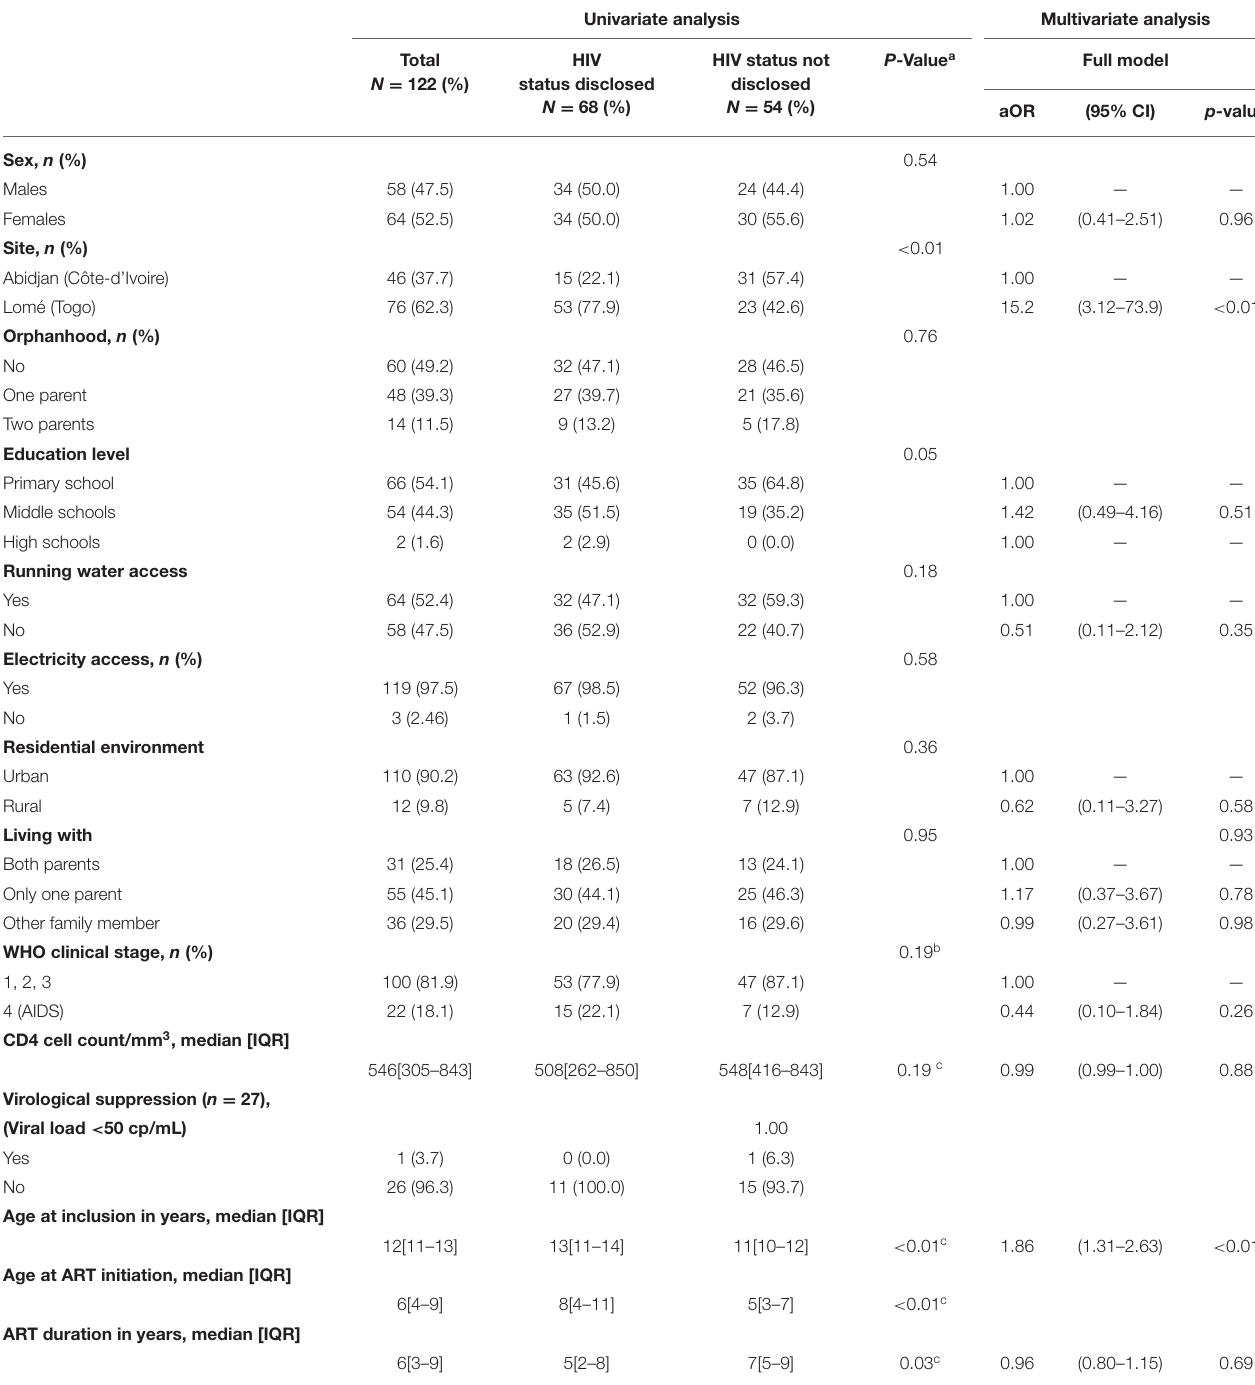
TABLE 4 | Correlates of HIV disclosure at 24-month among the 122 APHIV not disclosed at inclusion, in the COHADO cohort, Abidjan (Côte d’Ivoire), Lomé (Togo), IeDEA-pWADA, 2015–2017. Univariate analysis Multivariate